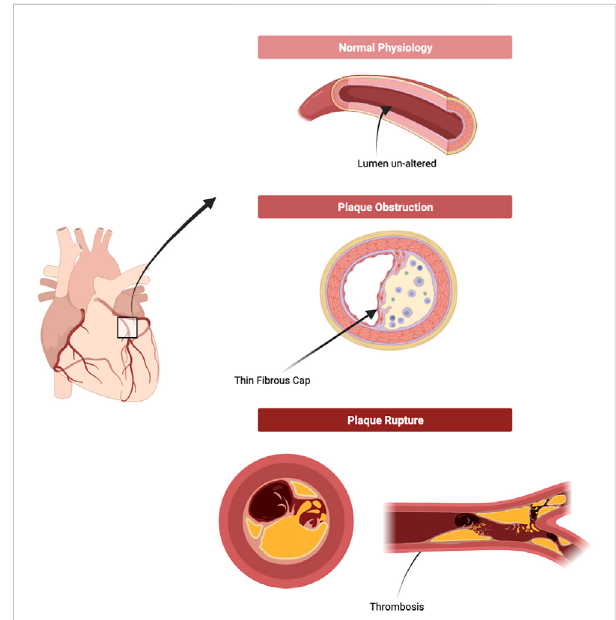
FIGURE 2 Plaque formation and Rupture. As the plaque develops, the lumen consequentially narrows as the necrotic core of the atheroma alters the structure of the blood vessel irreversibly. A narrower lumen increasesbloodpressure,puttingmorestrainonthebloodvessel and on the plaque. On top of this, in fl ammatory bodies continue to erode and disrupt the plaque, increasing the likelihood of rupture. Upon rupture, contents of the necrotic core and fragments of the plaque are released freely into the blood vessels and are the leading cause of thrombosis or thrombo-embolism. (Figure made with